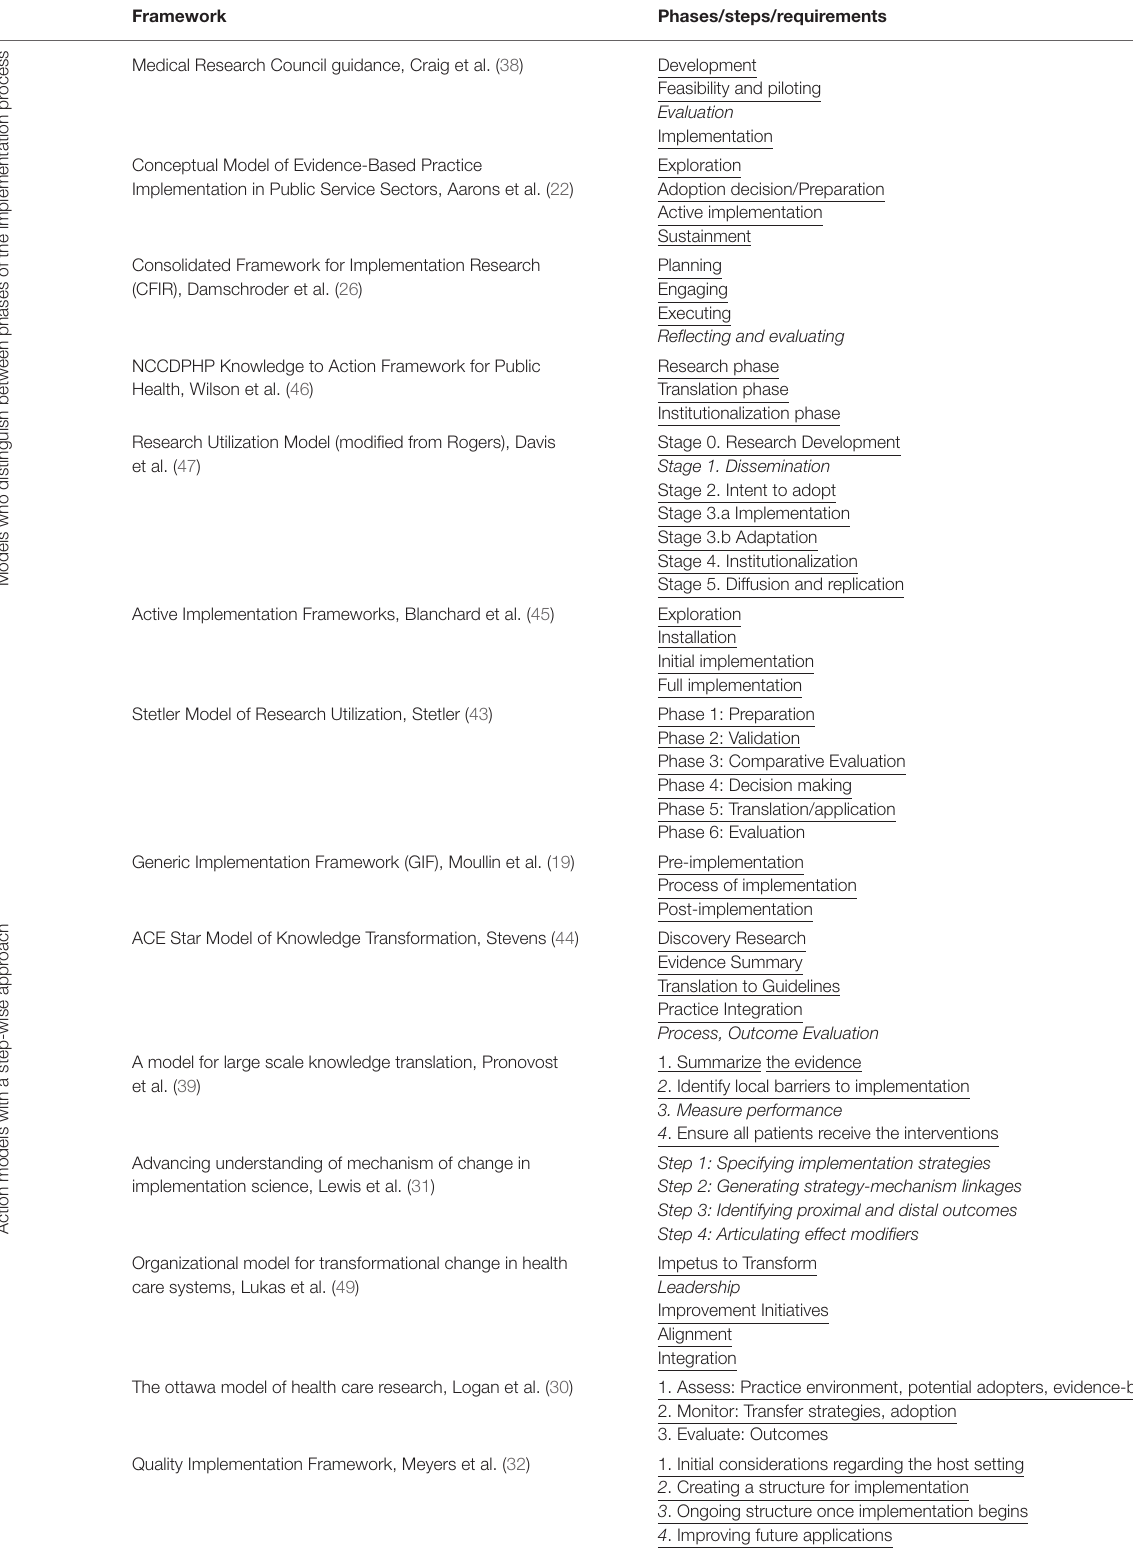
TABLE 4 | Overview of process models with their main phases, steps, or